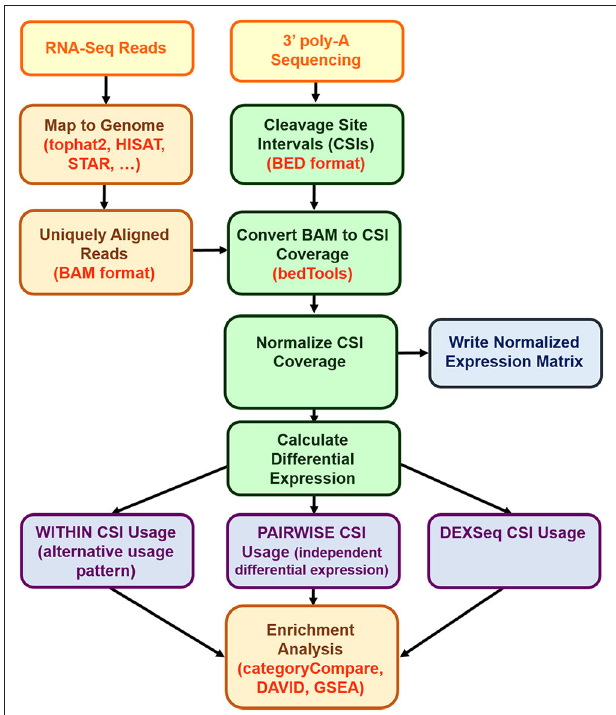
FIGURE 2 | CSI-UTR process diagram. (Yellow = external data sources; orange = external programs; green = CSI-UTR algorithms; purple = differential expression results; blue = output files). The input into CSI-UTR requires two sets of inputs: uniquely aligned input reads in BAM format